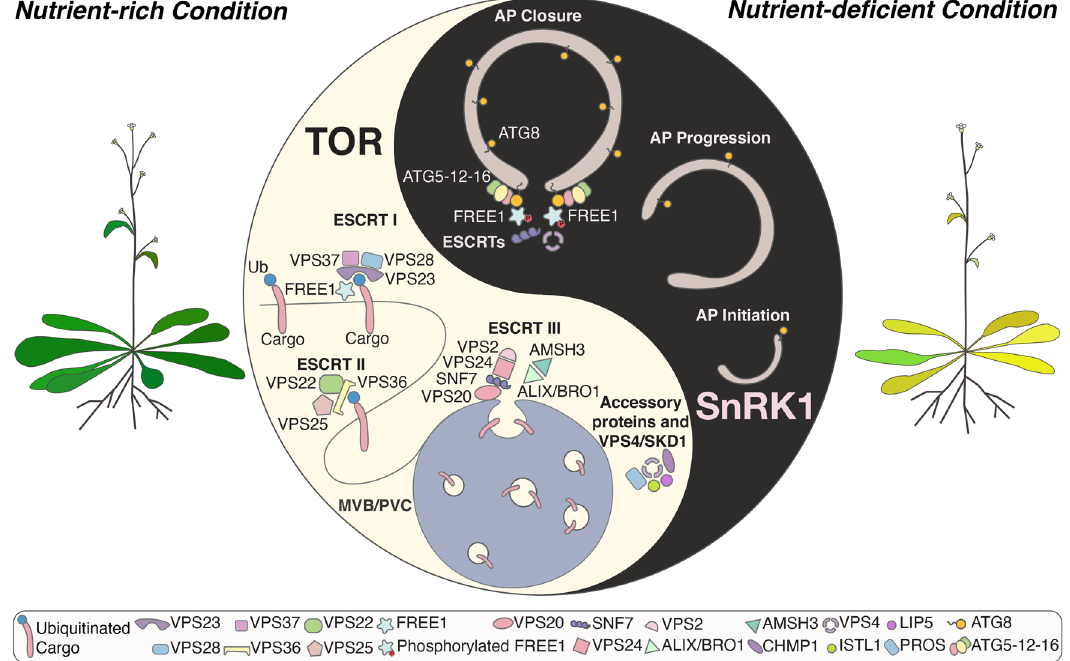
Fig. 6 | Working model of the interplay between the ATG conjugation system and the ESCRT machinery in regulating autophagosome closure in plants. Under nutrient-rich condition, FREE1 functions in endosomal sorting. During nutrient-de fi cient condition (autophagy induction), SnRK1 phosphorylates FREE1. The phosphorylated FREE1 is then recruited by the ATG conjugation system/ATG8